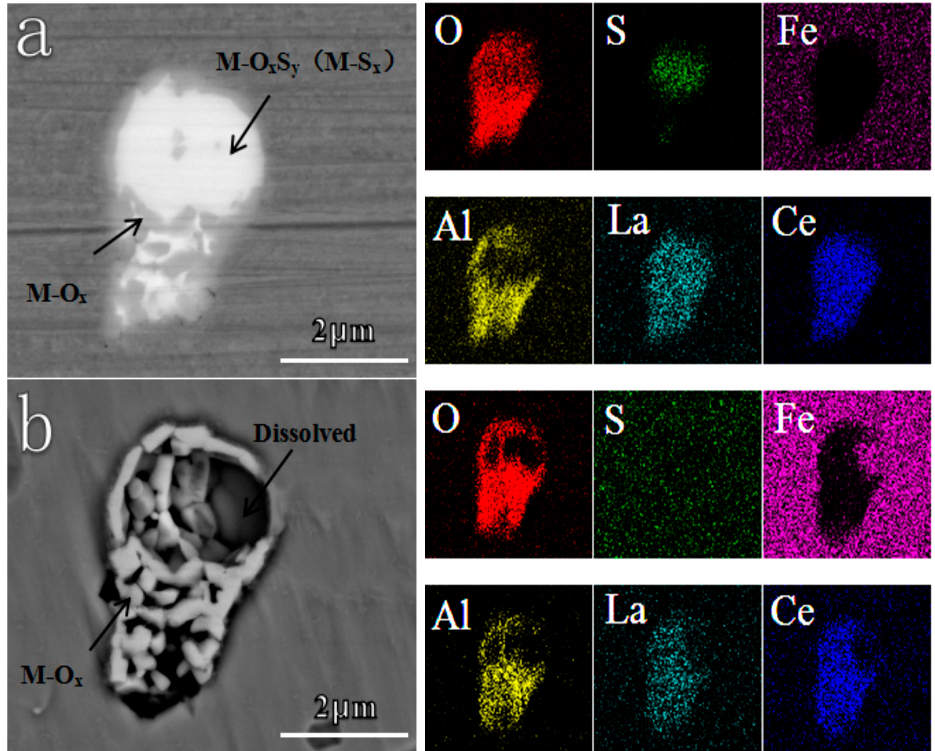
Figure 6. In-situ dissolution behavior of the inclusion in Al deoxidized steel after immersion in 0.5 wt.% NaCl for 10 min. ( a ) Before corrosion, ( b ) after corrosion.